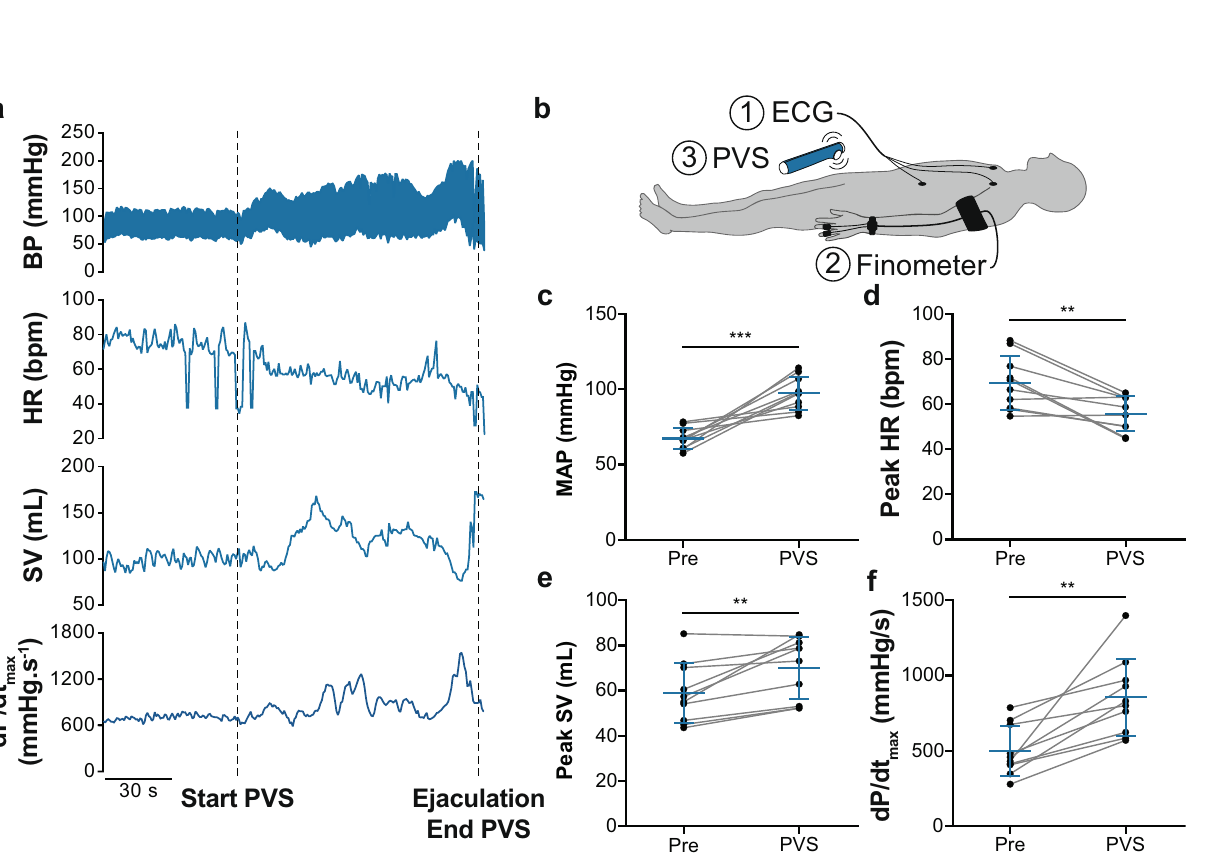
Fig. 8 Effects of minocycline on catheter-derived cardiovascular outcomes in rats with T3 severe contusion SCI. a Methods timeline: T3 contused (400 kdyn, 5 s dwell time) male Wistar rats (10 – 11 wks of age) were administered (I.P.) vehicle (control) or minocycline every 12 h for 2 weeks. At 8 weeks post SCI, catheterization (terminal procedure) was performed to assess hemodynamics and left ventricular (LV) function (see Fig. 4 for catheterization details). b Surgical setup at termination, described in Fig. 4 and created with BioRender.com. c Representative inferior vena cava (IVC) occlusions with the line representing end-systolic elastance (E es ; index of contractility). d E es ( n = 5 – 6/group), e maximum pressure (P max ; n = 5 – 6/group), and f maximal rate of systolic pressure increment (dP/dt max ; n = 5 – 6/group) were signi fi cantly higher in minocycline-treated vs. vehicle-treated rats. g Mean arterial pressure (MAP) was not signi fi cantly different between the groups. h Representative immuno fl uorescence images of the rostral ventrolateral medulla with dopamine beta-hydroxylase (DBH; green), FluoroGold (FG; white), and neuronal nuclei (NeuN; purple) stains. Arrows point to DBH/FG/NeuN positive cells. For replication please note that the count represents the number of FluoroGold/DBH-positive neurons located in the RVLM. Scale bar = 100 µ m. i Minocycline-treated rats have more DBH/FG/NeuN positive cells than vehicle ( n = 4/group). Catheter-derived data are presented as mean ± SD, and histological data are presented as median with the interquartile range. Individual rats are represented as symbols. All data in panels d – g were analyzed using a two-way independent t -test: * p < 0.05 and ** p < 0.01. See Supplementary Table 7 for detailed statistics and other catheter-derived outcomes. Source data are provided for all variables shown in this fi gure in the source data fi le.